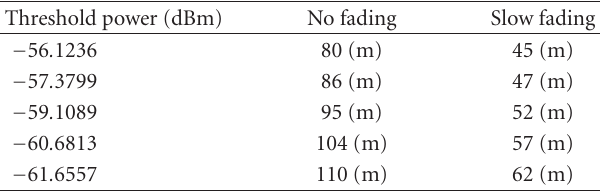
Table 2: Comparing the distance from PU under fading and no fading.